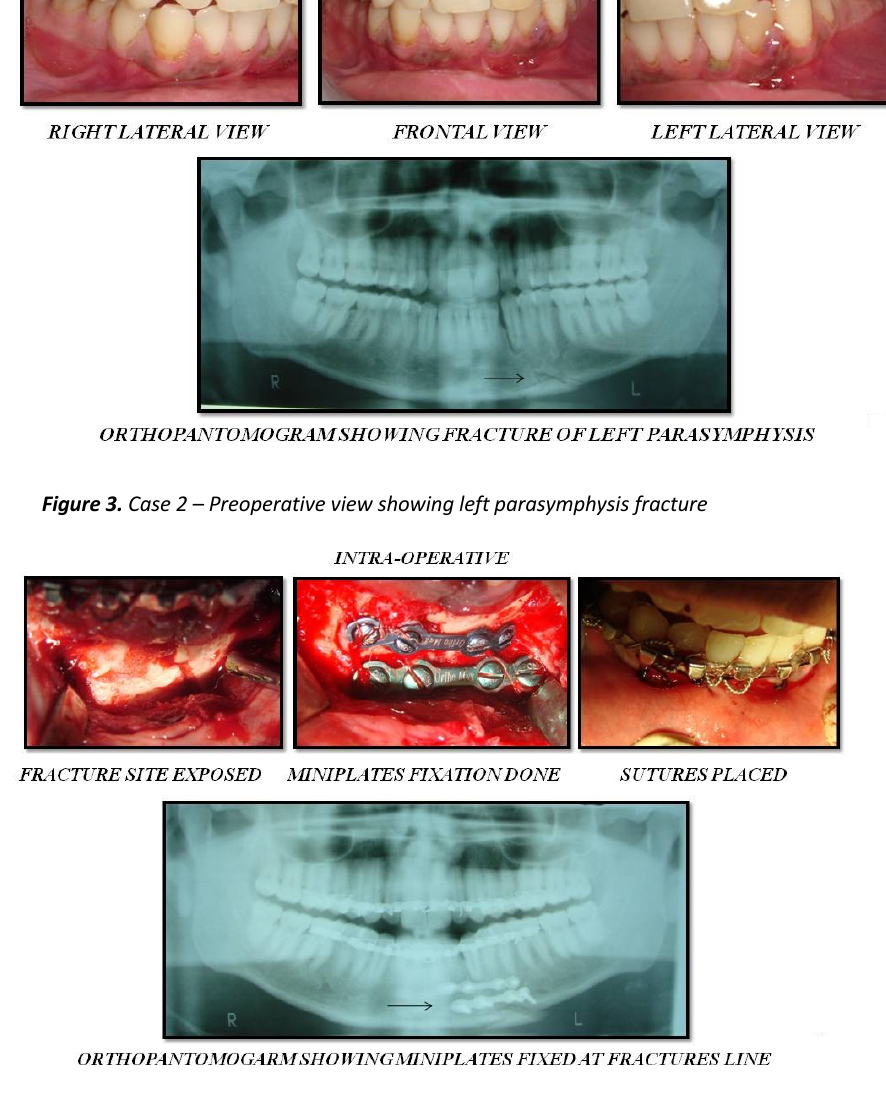
Figure 4. Case 2 – Placement of two 2-D